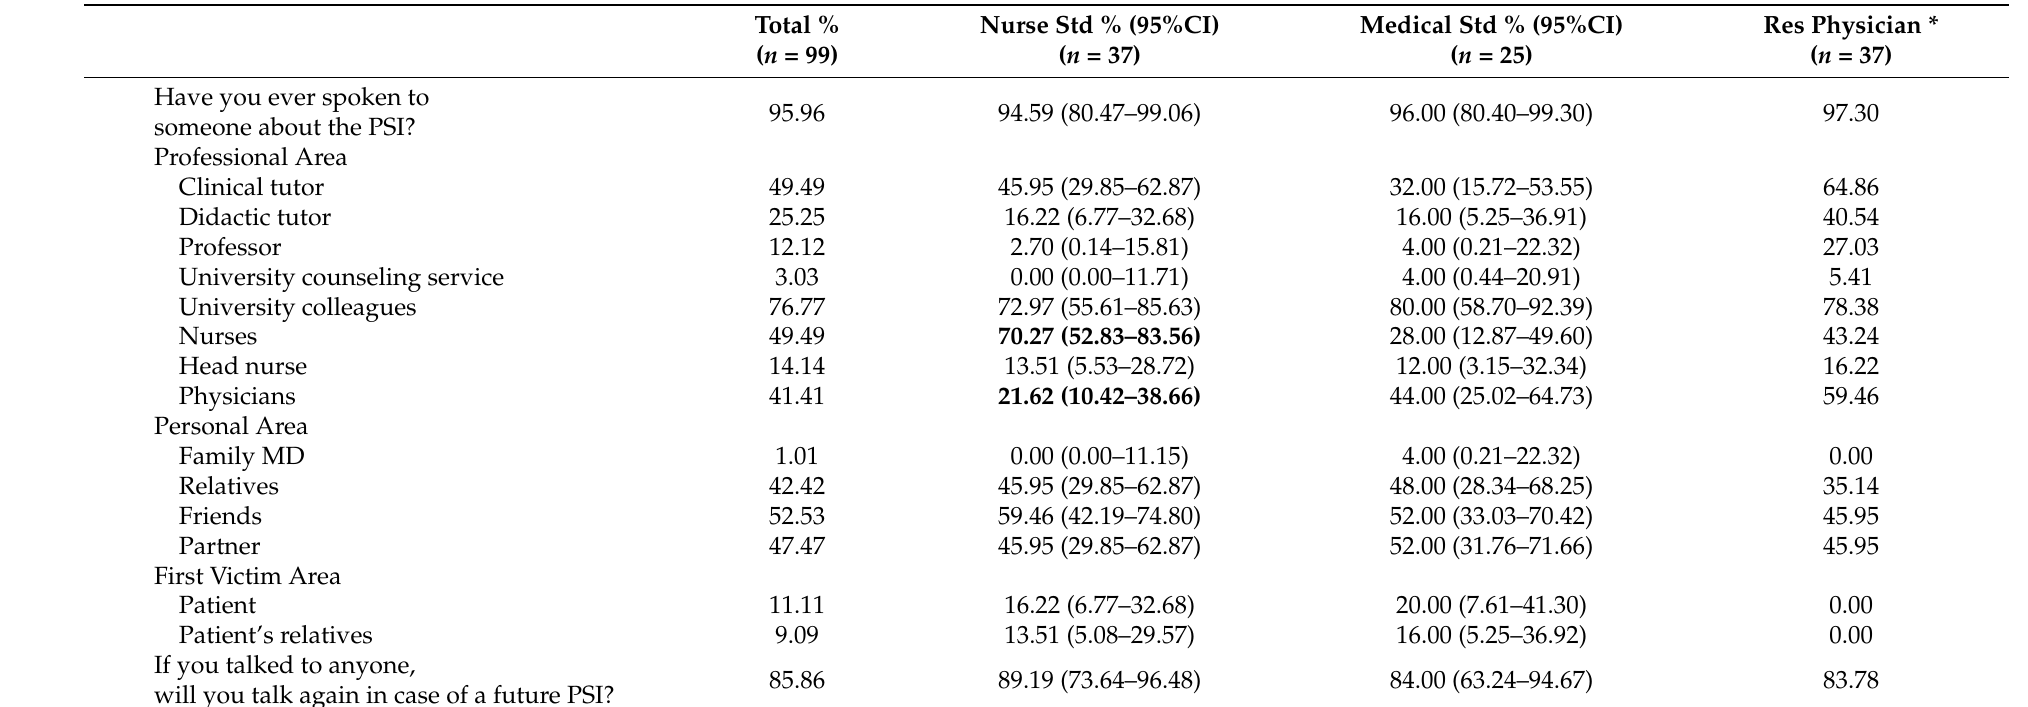
Table 3. Responder behavior after the PSI. Statistically significant results are highlighted in bold